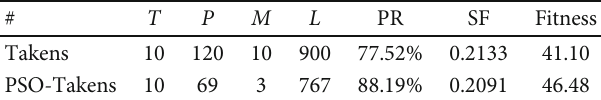
Table 3: Parameter changes of hip joint prediction algorithm under standard gait data.